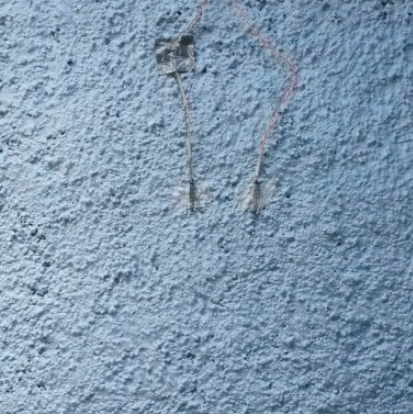
Figure 1. The phase change material (PCM)-perlite composite placed on mineral wool insulation component.